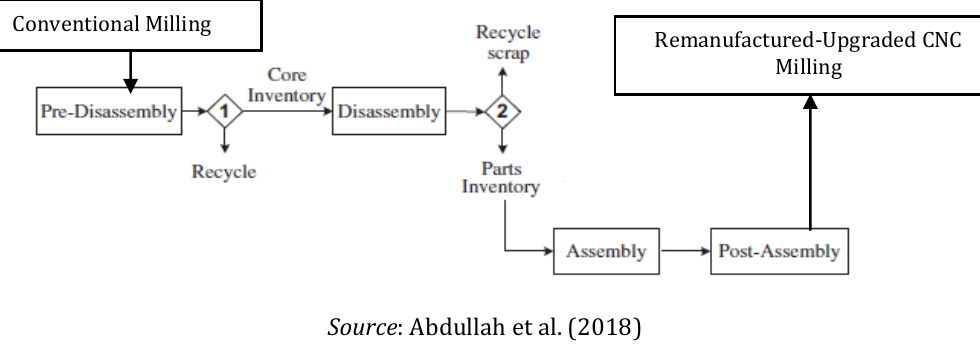
Source : Abdullah et al. (2018) Figure 13: Conventional technology based remanufacturing system